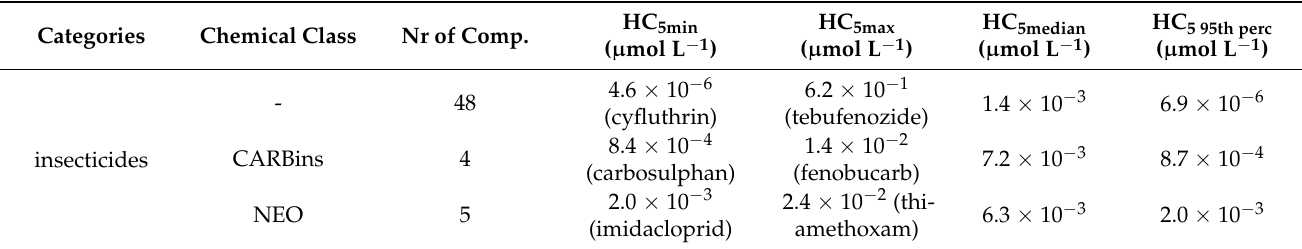
Table 2. Synopsis of the median HC 5 values ( µ mol L − 1 ) with their range of variability (minimum, maximum, and 95th percentile values for all the investigated HC 5 ) for classes of